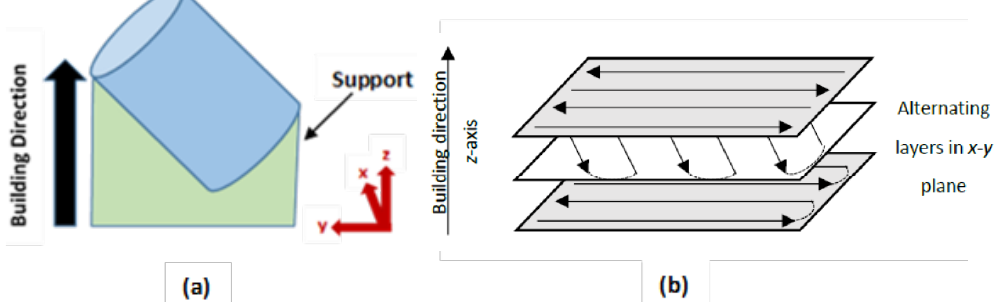
Figure 1. ( a ) Illustration of the cylindrical specimen manufactured in the 45° direction with respect to the building direction; ( b ) Schematic illustration of the scanning strategy [13].